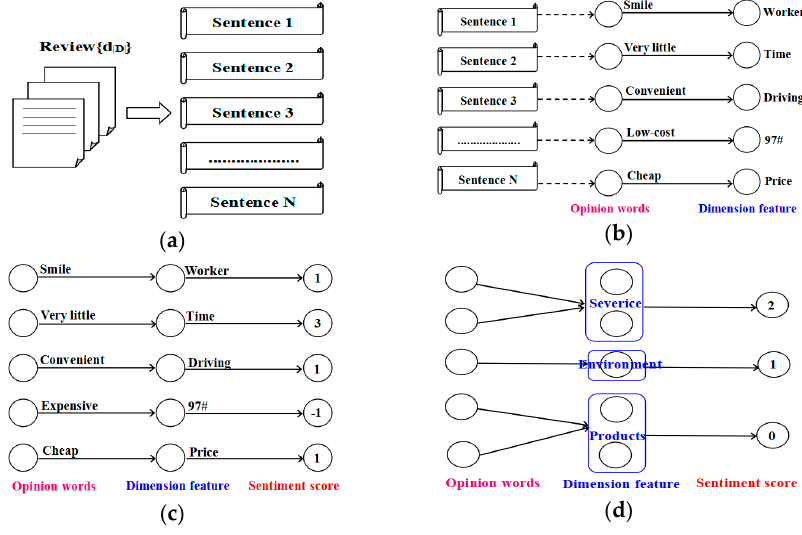
Figure 5. Dimension semantic information of gas station extraction. ( a ) Review text of a gas station; ( b ) Extracts feature-opinion word pairs; ( c ) Sentiment scores of each sentence calculation; and ( d ) Construct tripartite graph of dimension sentiment.